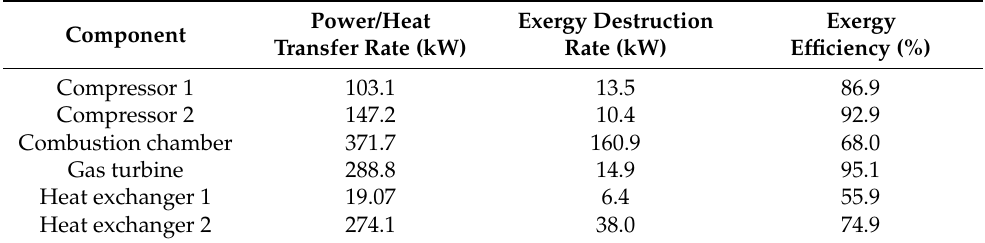
Table 8. Thermodynamic analysis of Brayton cycle components for the base